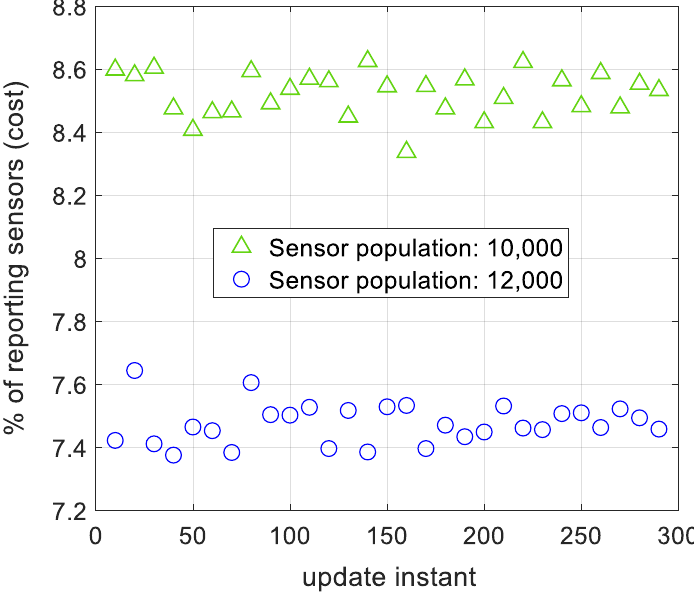
Figure 9. The percentage of reporting sensors to the FC for two different sensor populations. The number of reporting sensors does not tangibly change, when the sensor population